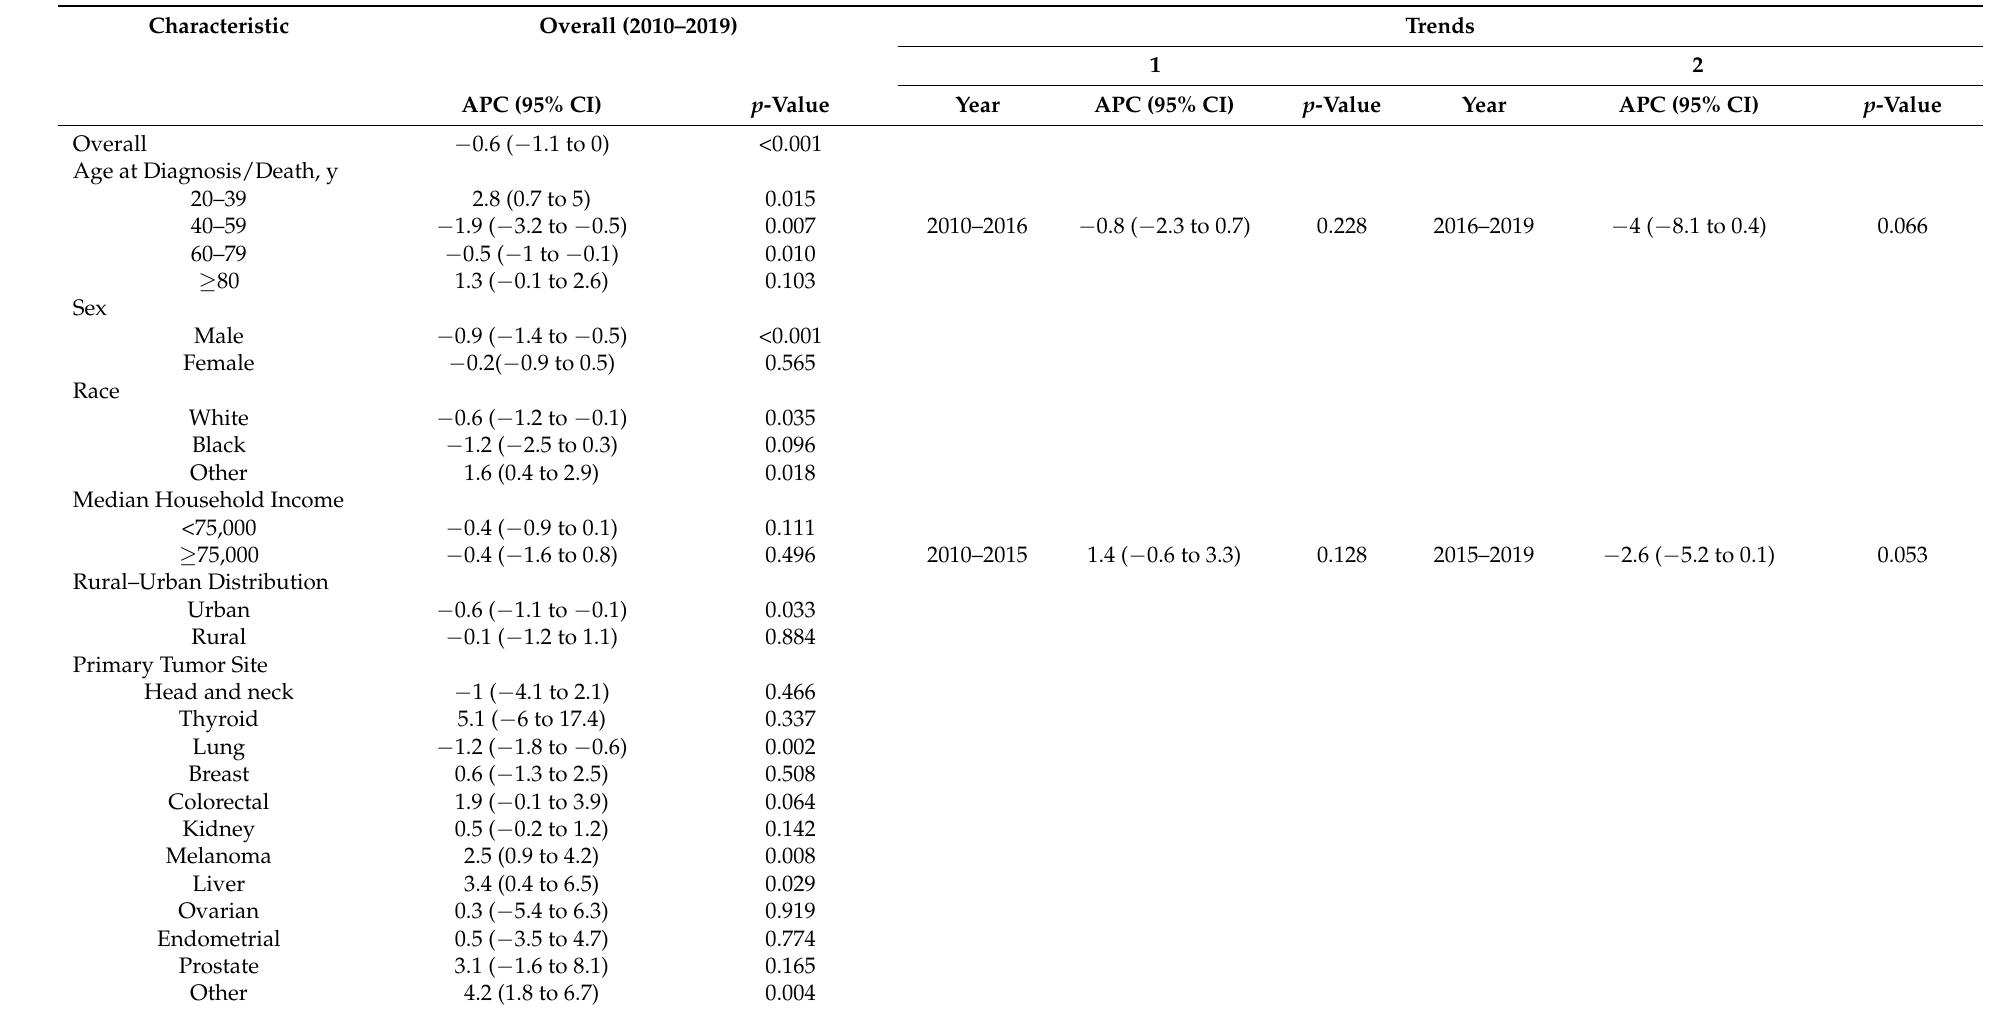
Table 2. Trends in SBM incidence rates* (2010–2019): the SEER-17 registry